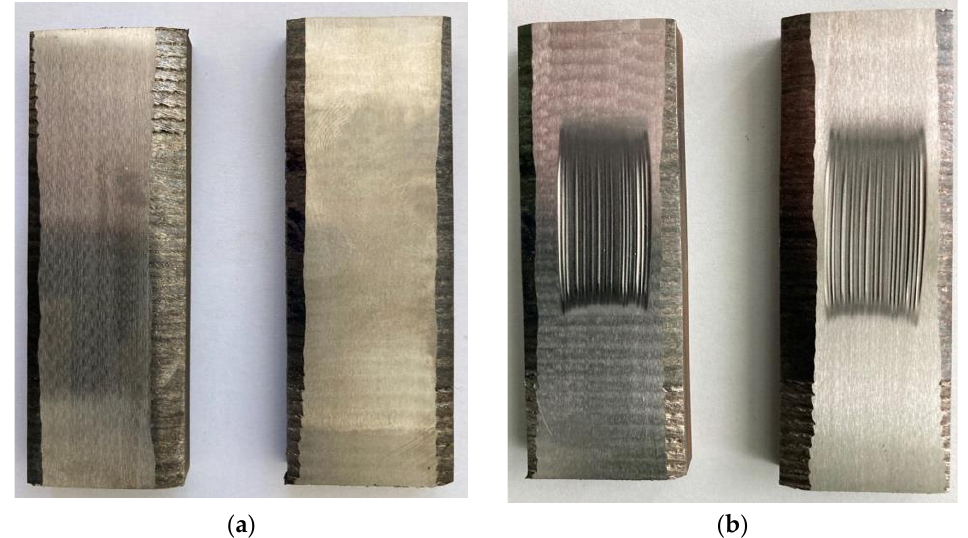
Figure 11. View of the selected examples of Inconel 625 CMT cladded coatings ( a ) before and ( b ) after the wear resistance test.